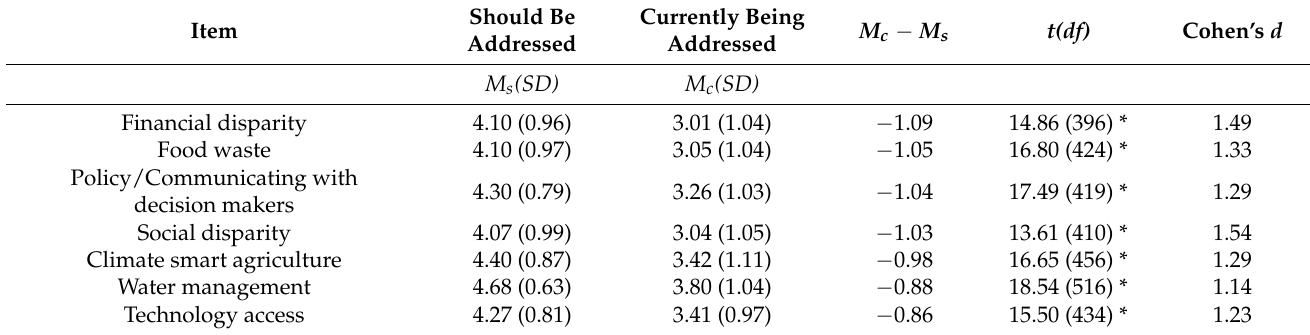
Table 2. Research and outreach needs—comparison of “should” be addressed to “currently” being